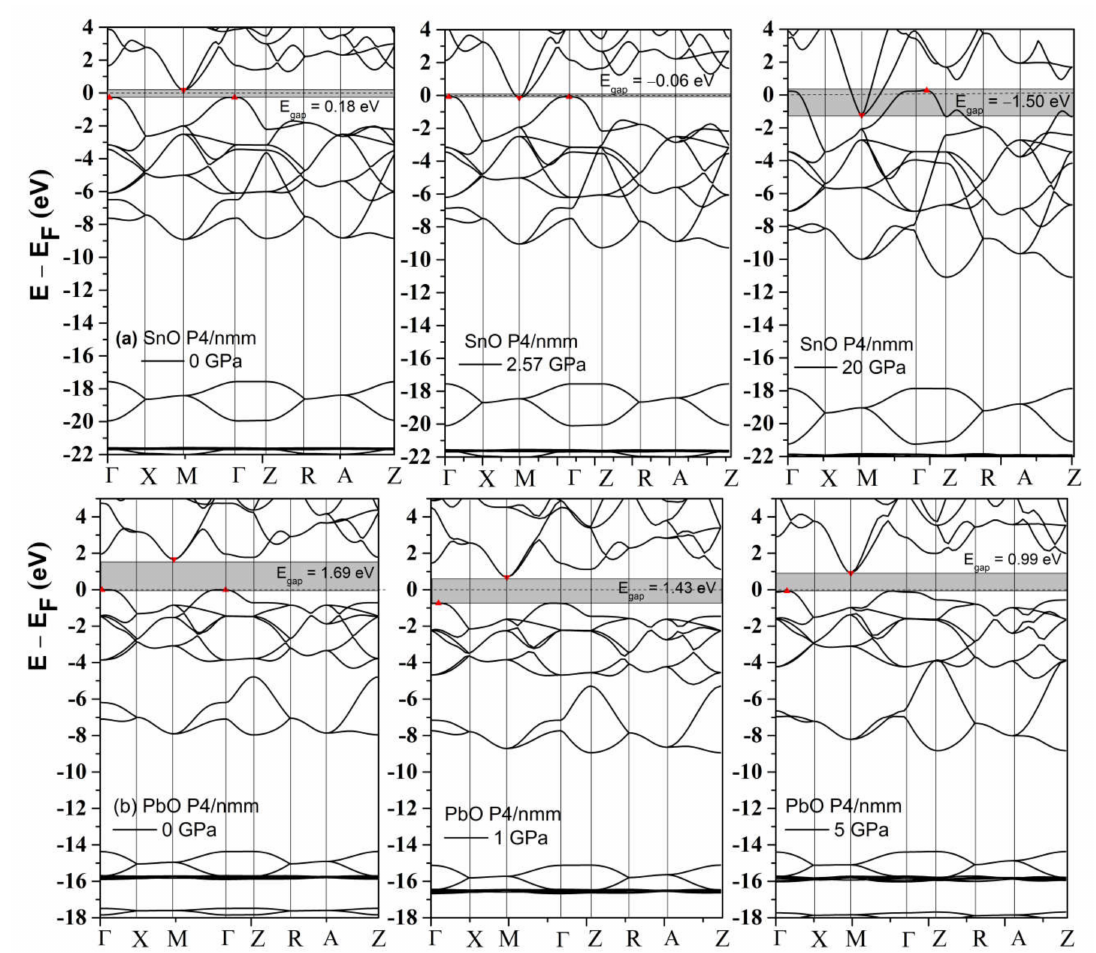
Figure 4. The calculated band structures of tetragonal SnO and PbO upon compression. The valence band maximum and conduction band minimum are marked as red triangle points.